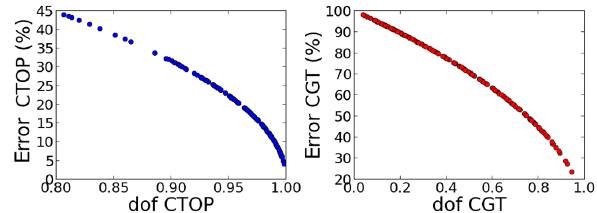
Figure 12. Relation between the DOFs and the a posteriori errors on CTOP (left) and on CGT (right).